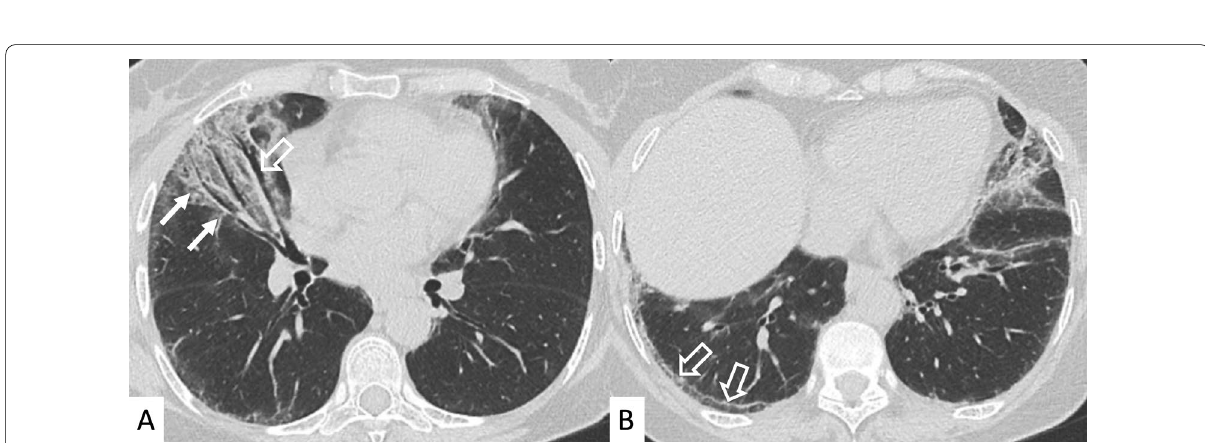
Fig. 16 NSIP pattern in a patient with PM. HRCT features include reticulations superimposed on ground-glass opacifications, as clearly depicted in the middle lobe (white arrows); traction bronchiectasis (empty white arrow) can also be appreciated in the same area. Subpleural reticulations are also evident in B , in the basal part of the right lung (empty white